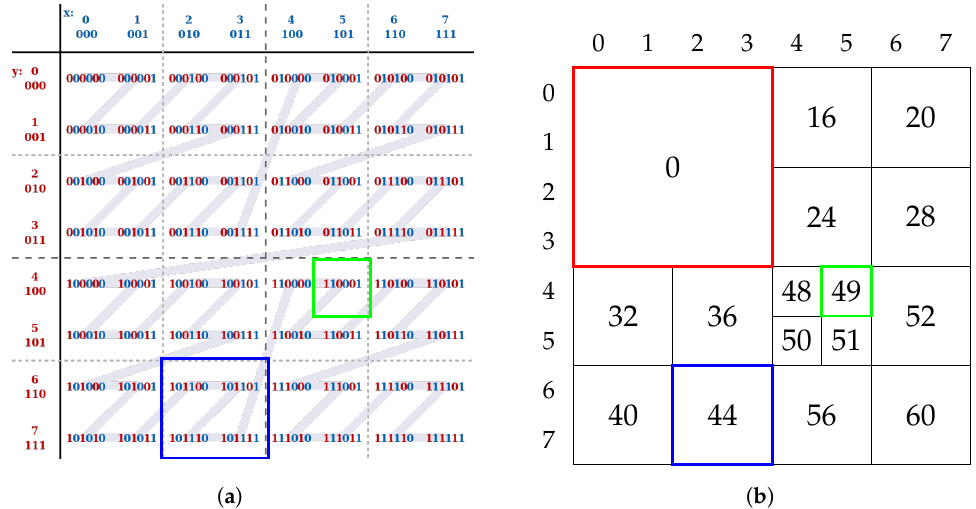
Figure 14. Linear quadtree generation from a grid. ( a ) Morton code computation: Its value is computed by alternating a column digit (blue) and a row digit (red) [39]. ( b ) Linear Quadtree